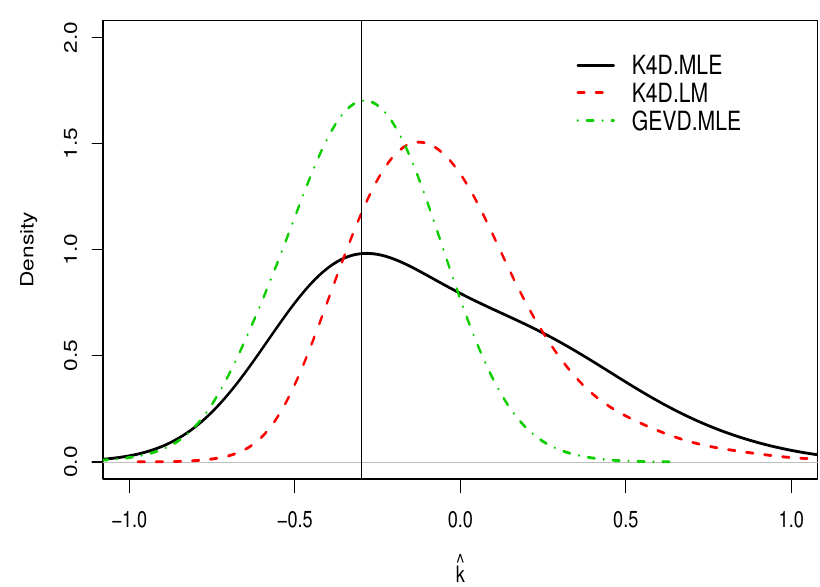
Figure 2. Probability density plots obtained by the kernel method in which the parameters are estimated using different methods (L-moment estimation, maximum likelihood estimation) from random samples of the four-parameter kappa distribution (K4D) with k = − 0.3 and h = − 0.01 and sample size n = 30. The vertical line represents the true value of k . GEVD: generalized extreme value distribution, LM: L-moment estimation, MLE: maximum likelihood